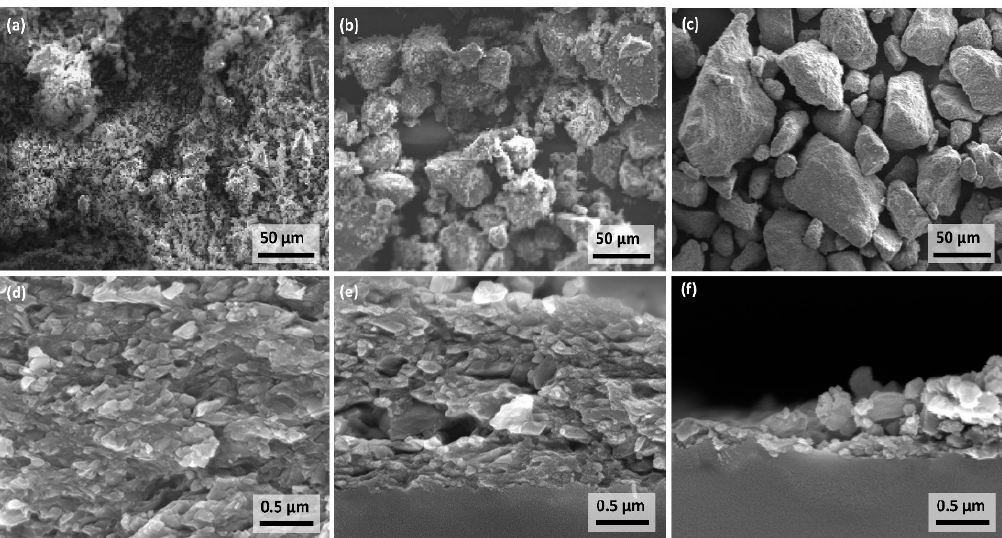
Figure 4. Development of powder agglomeration over deposition time for powder in the fluidized bed generator after runs ( a ) 1, ( b ) 4, and ( c ) 6, and corresponding fracture cross section of the respective film morphology for ( d ) 1, ( e ) 4, and ( f ) 6. Powders were probed from fluidized bed generator after each run.